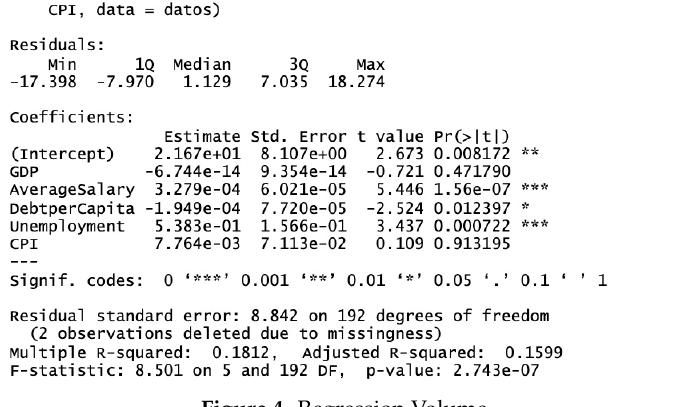
Figure 4. Regression Volume.